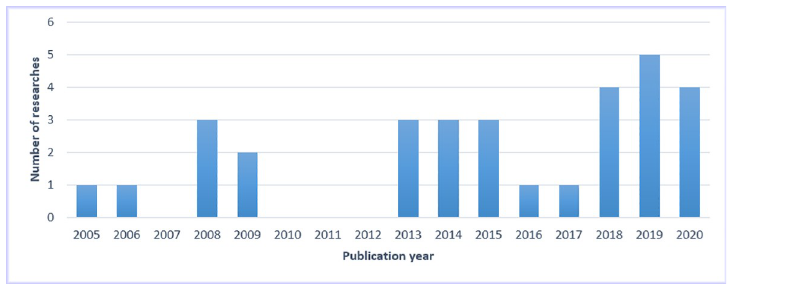
Fig 2. Number of studies published each